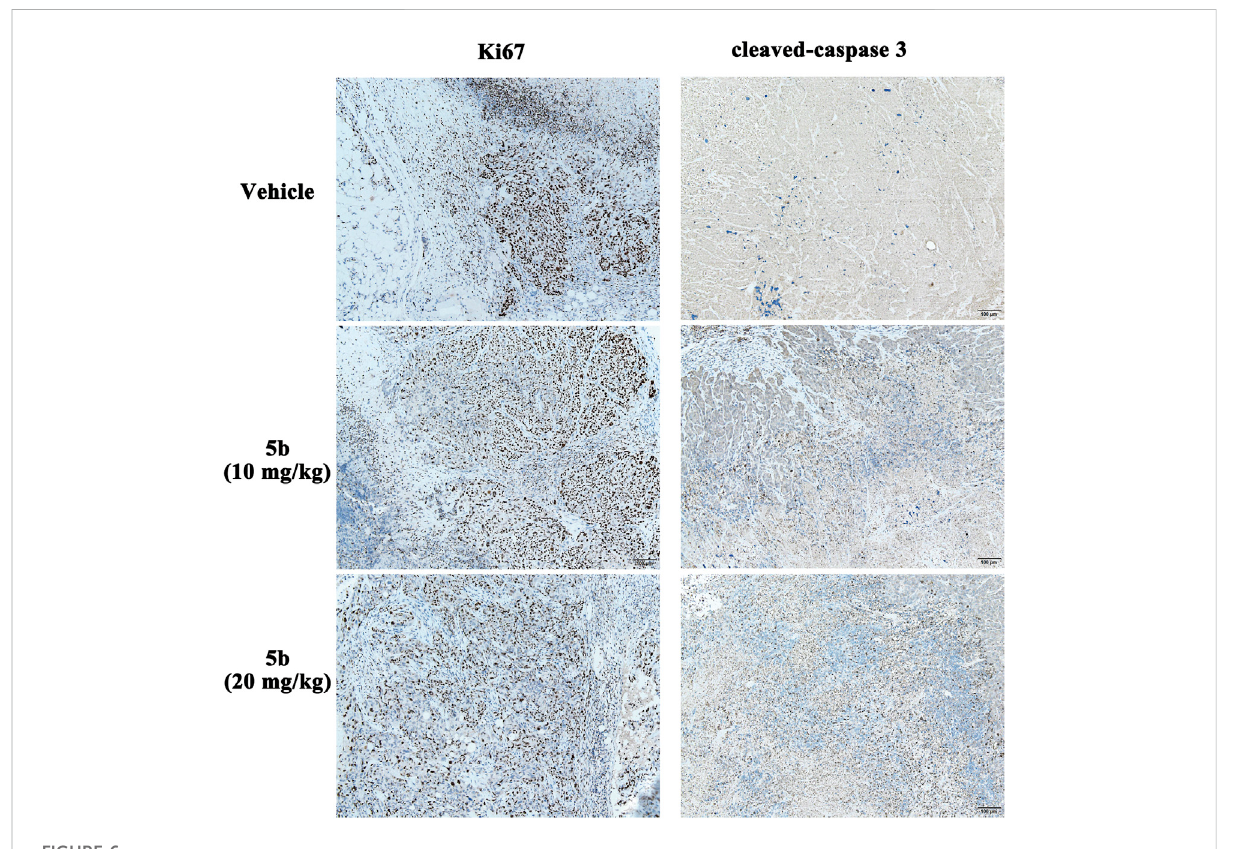
FIGURE 6 Expression of Ki-67 and CC3 in HCT116 tumor